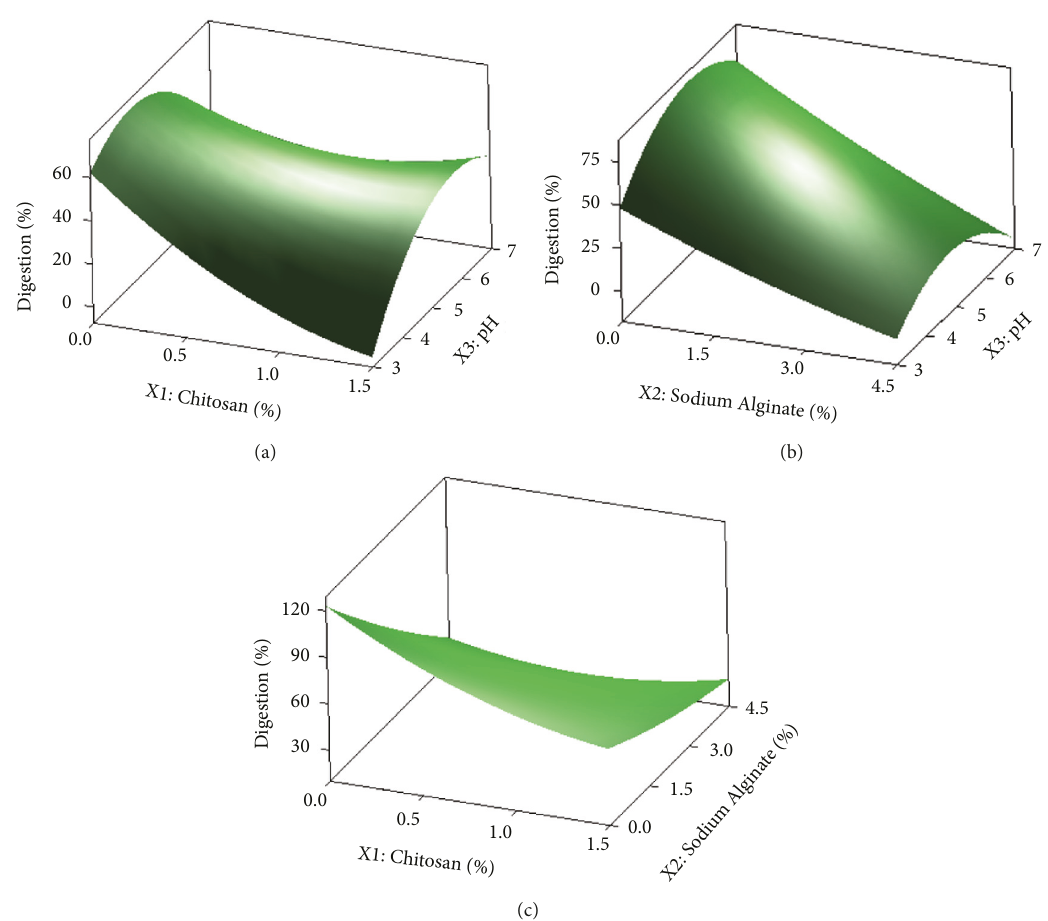
Figure 6: Three-dimensional plot of microencapsulation digestion. (a) Microencapsulation digestion vs. chitosan concentration. (b) Microencapsulation digestion vs. sodium alginate concentration. (c) Microencapsulation digestion vs. chitosan concentration and sodium alginate concentration.